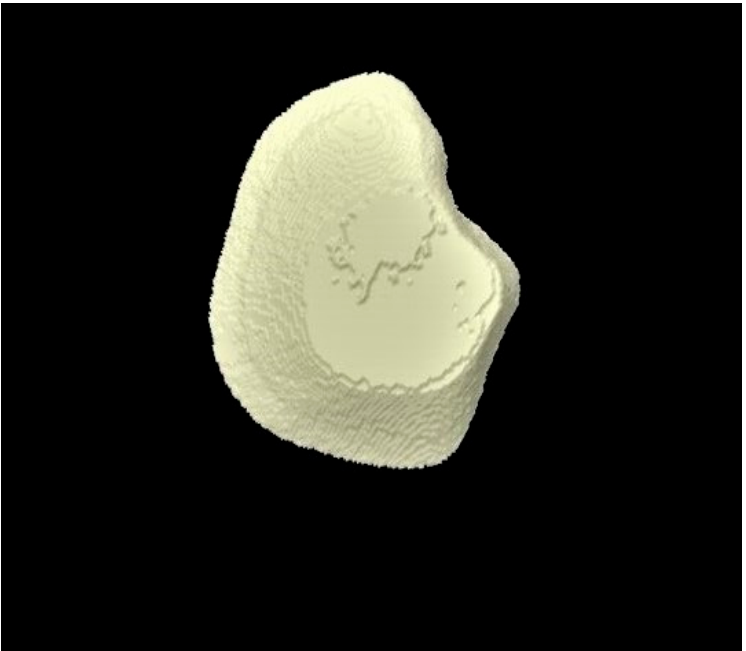
Figure 10. Micro-CT image of group 3 samples presenting enamel surface post-remineralization.